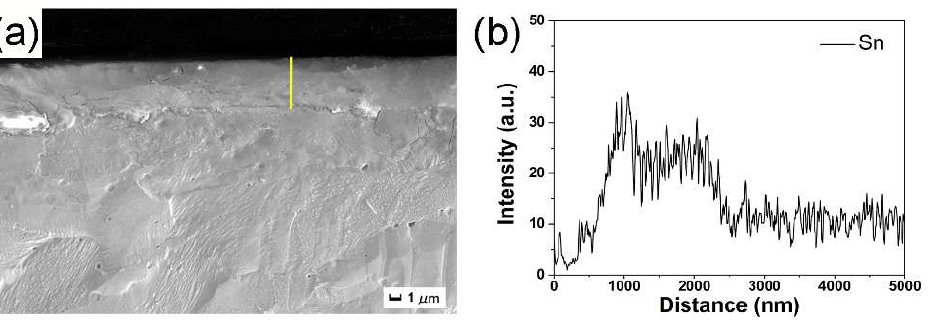
Figure 3. ( a ) Cross-sectional SEM images of the Sn alloyed sample irradiated by 30 pulses, and ( b ) EDS line analysis of the yellow line in ( a ). ( b ) EDS line analysis of the yellow line in ( a